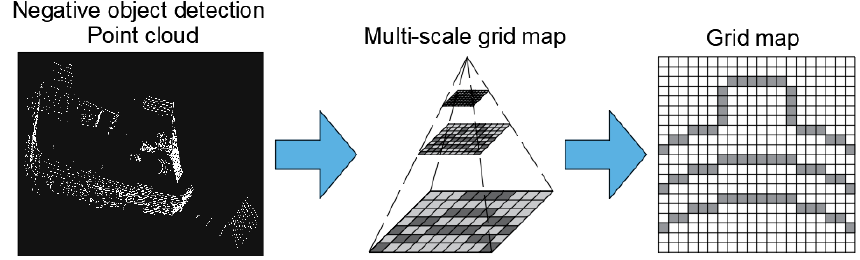
Figure 6. Rasterize. Figure 6.